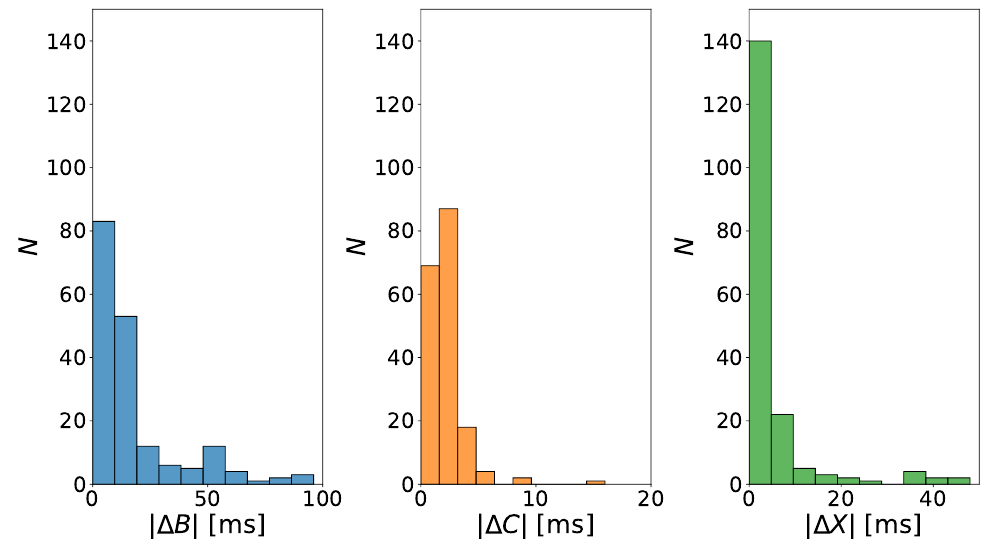
Figure 5. The histograms illustrating the dispersion of mean absolute differences | ∆ B | , | ∆ C | , | ∆ X | in the detection times of the B, C, and X points, respectively. The number N stands for the number of observations corresponding to the presented time intervals.